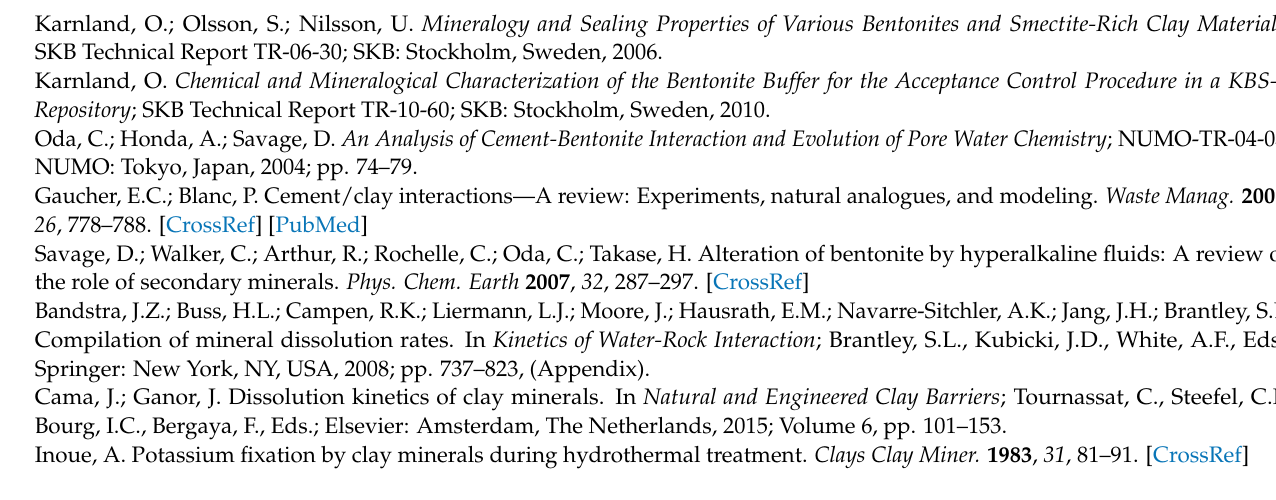
Figure A5. XRD patterns of montmorillonite after EG treatment. ( A ) LAC-MX_4.9 y, ( B ) LAC-MX_10 y, ( C ) OPC-MX_4.9 y, and ( D ) OPC-MX_10 y. This figure shows an enlargement of 8–20° 2θ in Figure 8.